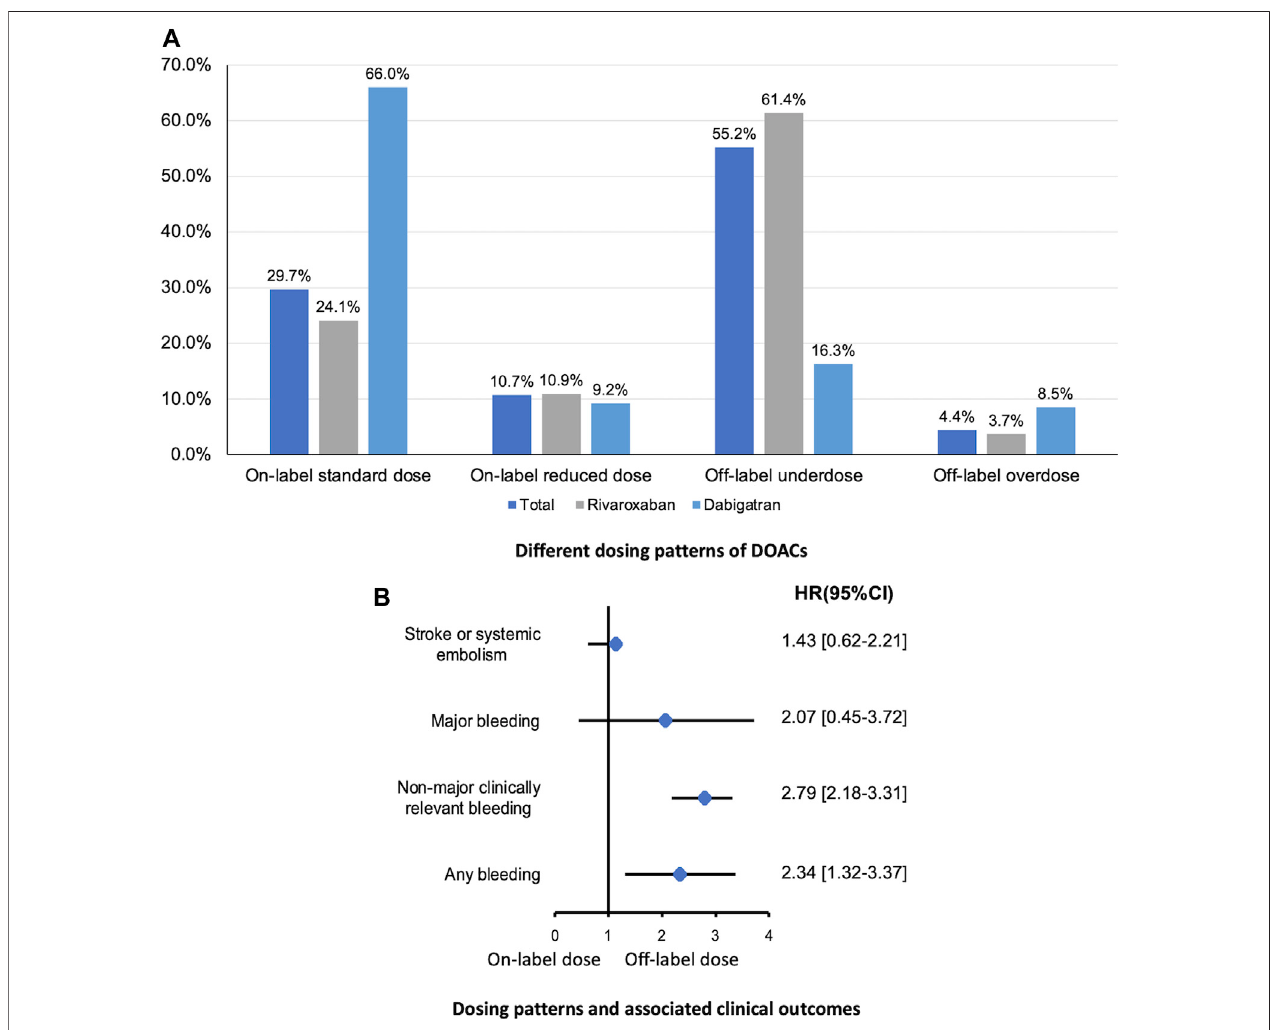
FIGURE 2 | Different dosing patterns of DOACs (A) and associated clinical outcomes (B) in patients with eCrCl < 50 ml/min calculated by CG equation. DOAC, direct oral anticoagulants; eCrCl, estimated creatinine clearance; CG, Cockcroft-Gault.